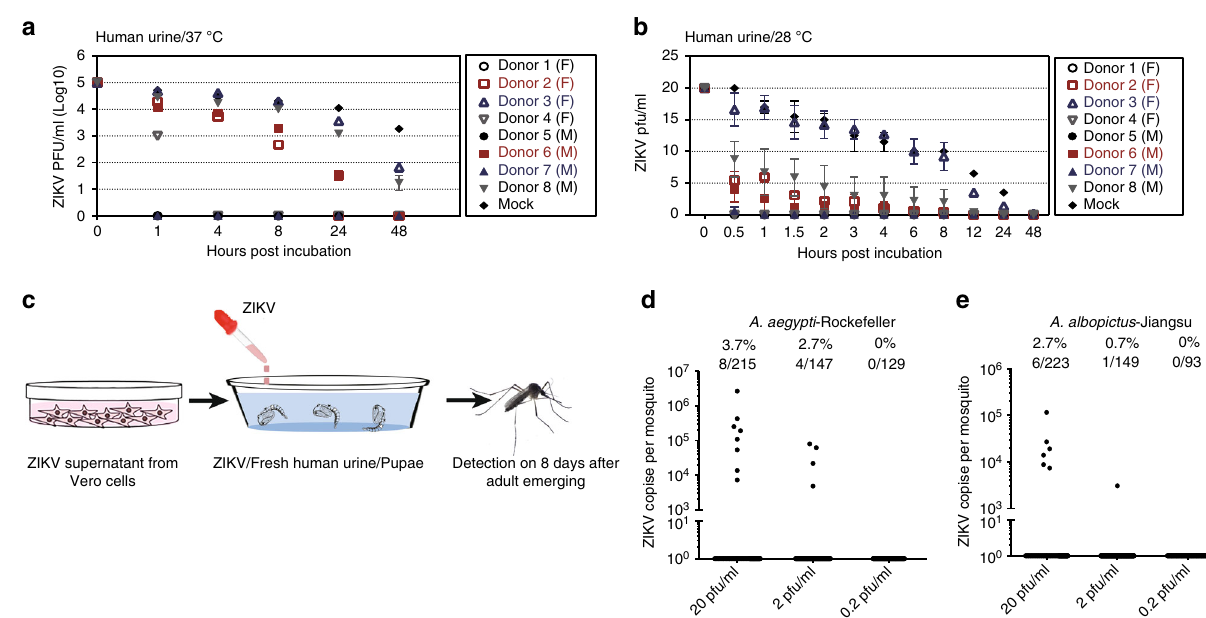
Fig. 1 Mosquitoes are permissive to Zika virus (ZIKV) infection during breeding. a , b ZIKV survivability in human urine. ZIKV was incubated with fresh human urine or phosphate-buffered saline (PBS) (Mock). The mixtures were then maintained at either 37 °C or 28 °C over a time course and subsequently subjected to a viral titration assay. The PRVABC59 strain was used for the incubation. The initial ZIKV titer was 1 × 10 5 or 20 pfu/ml. Data are presented as the mean ± S.E.M. a n = 3 biologically independent samples. b n = 2 biologically independent samples. The data were repeated by two independent experiments with the similar results. F: female; M: male. c – e Acquisition of ZIKV infection by Aedes mosquitoes breeding in infectious human urine. c Experimental schematic representation. Freshly emerging mosquito pupae were used for breeding in ZIKV urine. The urine from human Donor 3 (Fig. 1a) was used in these experiments. Both ZIKV prevalence and infectivity were determined in the A. aegypti Rockefeller strain ( d ) and the A. albopictus Jiangsu strain ( e ). The mosquitoes were breeding from human urine with serial ZIKV titration. The emerging adults were reared for an additional 8 days for ZIKV detection by TaqMan quantitative PCR (qPCR). The number of infected mosquitoes relative to the total number of mosquitoes is shown at the top of each column. One dot represents one mosquito. The percentages are represented as the ratios of mosquito infection. a – e Source data are provided in as Source Data fi le